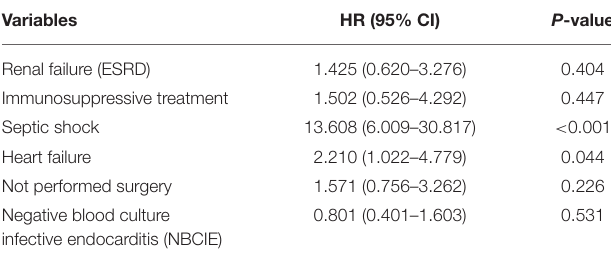
TABLE 4 | Frequency of systemic and cardiac complications during hospital admission.